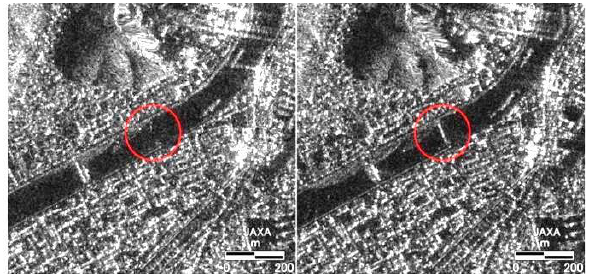
Figure 5. The loss of bridge in Kure City, Hiroshima Pref., Japan from comparison of the two HH amplitude images acquired after (July 8, 2018, left) and before (Apr. 19, 2015, right) due to heavy rain.